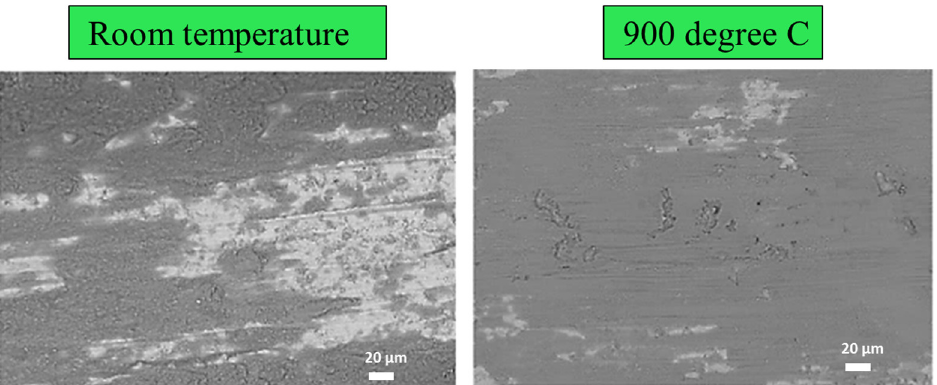
Figure 12. Wear morphologies of AlCoCrFeNiTi HEA coatings tested at room temperature and elevated temperature (secondary electron mode). The presence of contrast oxide regions was more profound when tested at room temperature compared to that at elevated temperature [14].